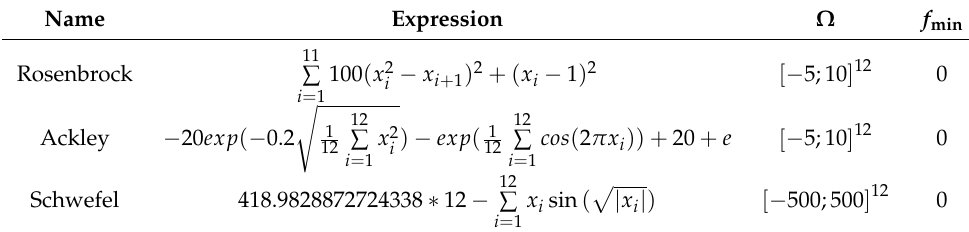
Table 1. Definition of the benchmark